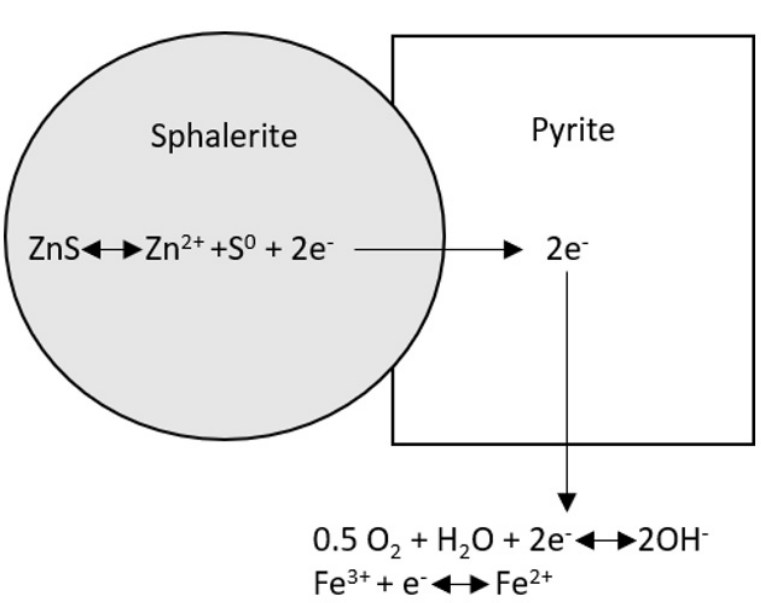
Figure 2. An example of mineral–mineral galvanic interactions between sphalerite and pyrite